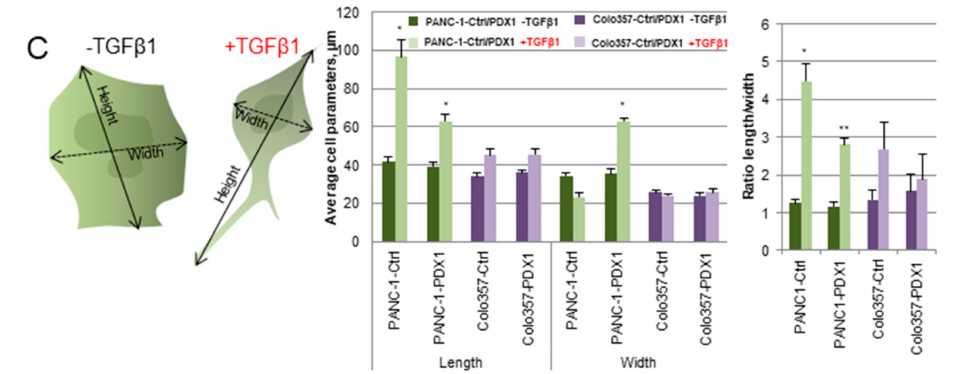
Figure 4. The sensitivity of Control and PDX1-expressing Colo357 and PANC-1 cells to TGF β 1-induced epithelial- mesenchymal transition (EMT). ( A , B ) Morphological changes in PANC-1-Control/PDX1 ( A ) and Colo357-Control/PDX1 ( B ) cells after treatment with TGF β 1 factor for 24 h. Magnification × 175. The white and black stripes correspond to a scale of 100 µ m. Red arrows indicate examples of fibroblast-like changes. ( C ) Changes in cell parameters cells after treatment with TGF β 1 factor for 24 h: length, width, length-to-width ratio. Data are presented as the mean ± SD. * p < 0.05, ** p < 0.01 compared with control group, Mann–Whitney test.